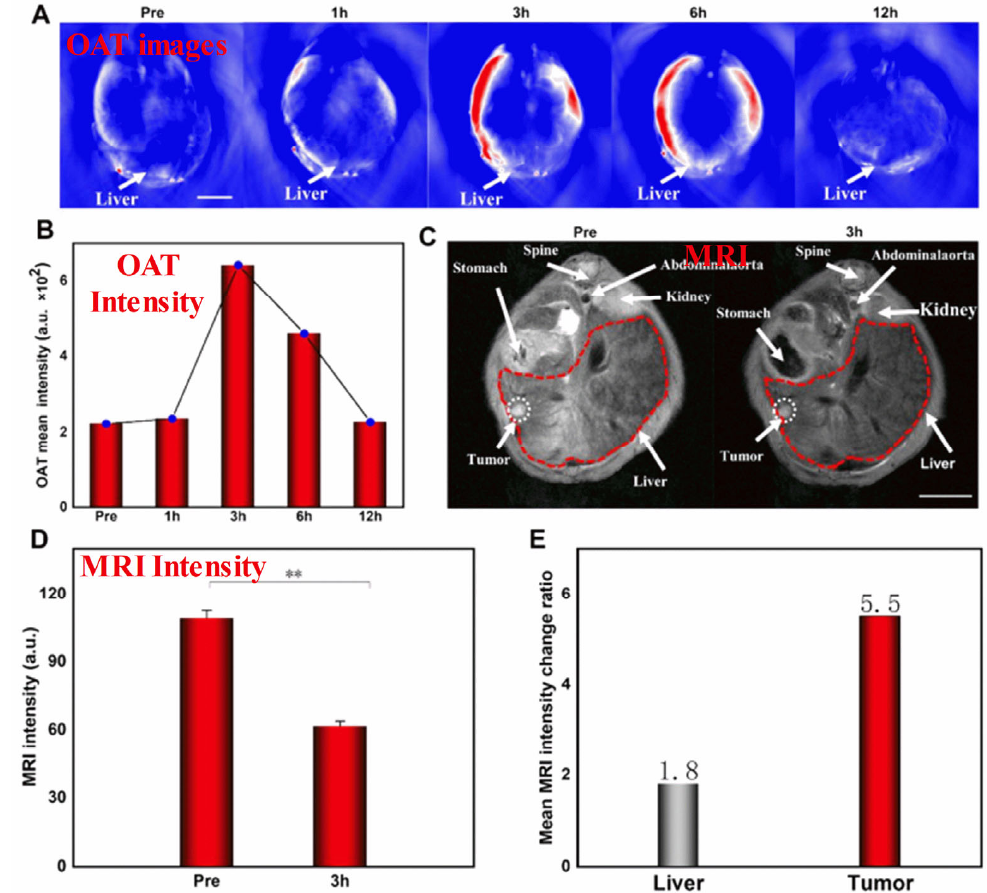
Figure 3. ( A – E ) In ‐ vivo OAT − MRI studies. In this study, Fe 3 O 4 @Au ‐ PEG ‐ EpCAM as a contrast agent, and HepG2 as the tumor cell. Reprinted from Ref. [128]. Copyright 2022 ACS. ** p